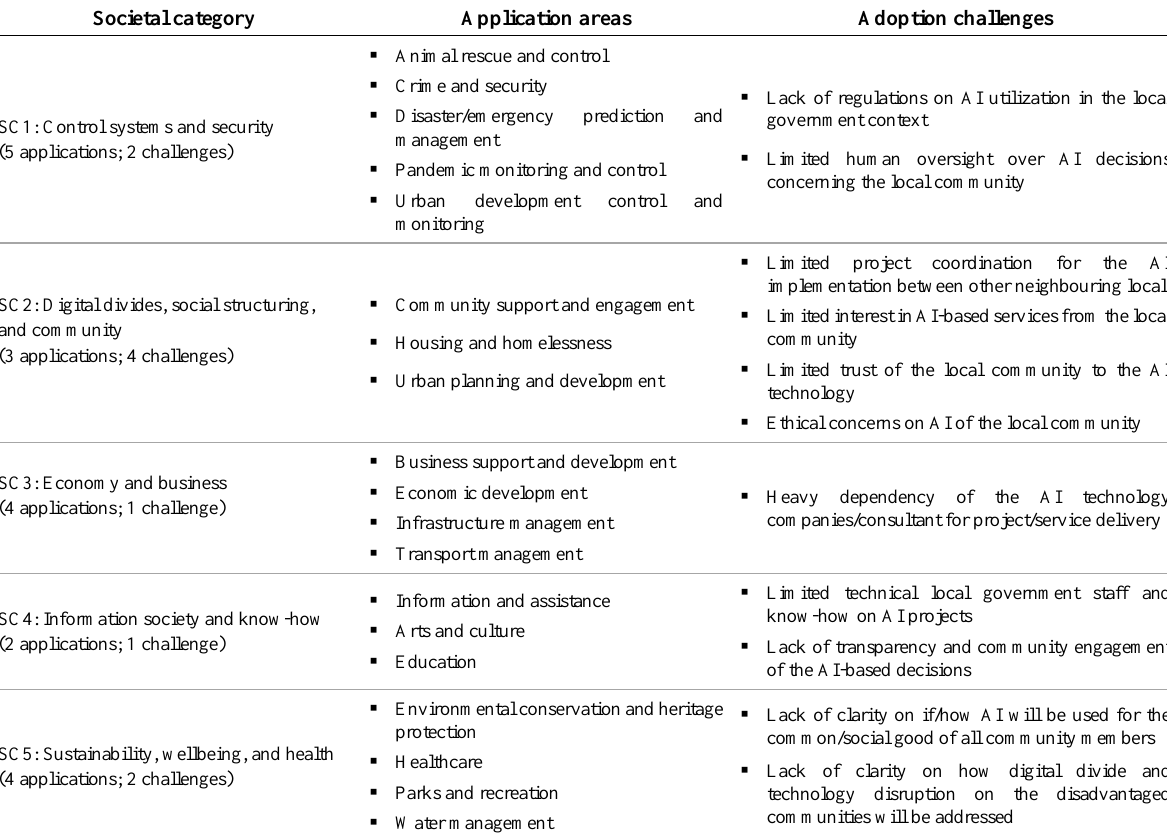
Table 1. Societal categories, application areas and adoption challenges of AI in urban services Societal category Application